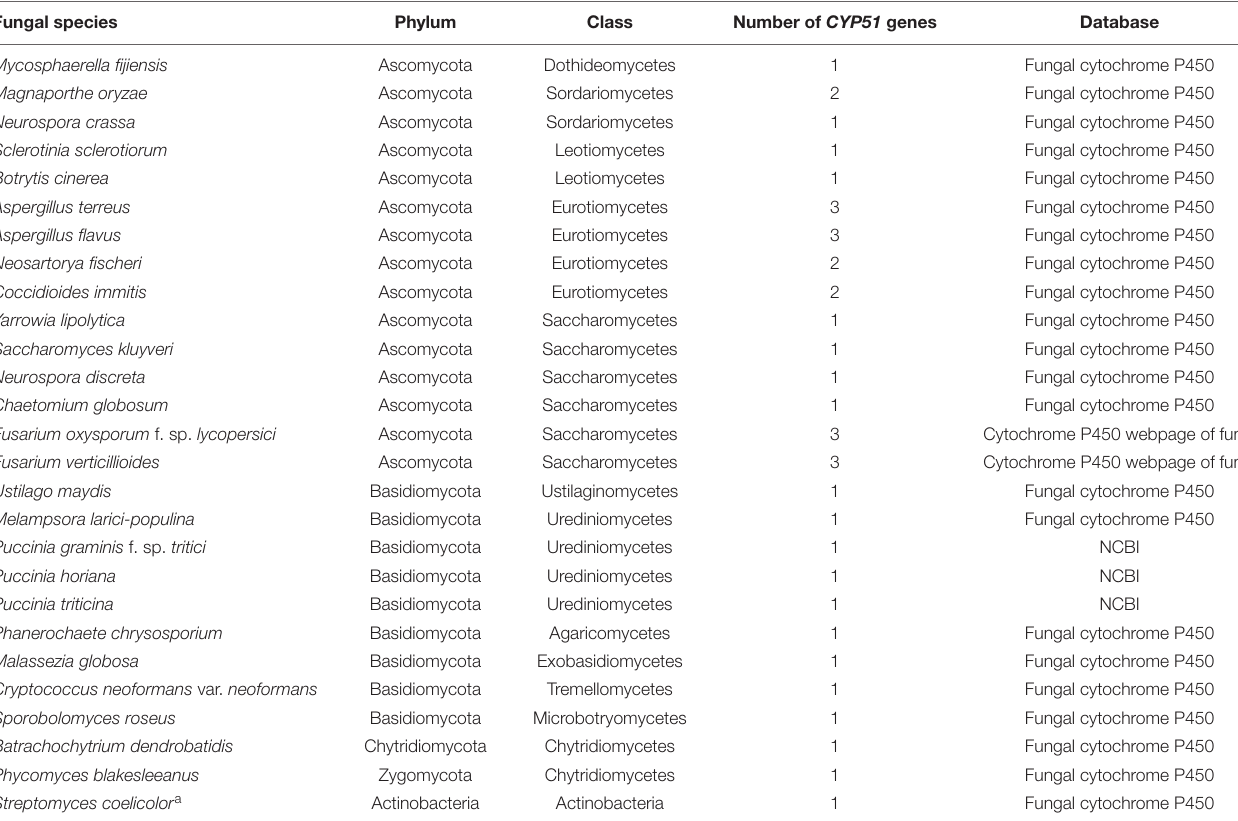
TABLE 1 | Fungal species used to compare sequences of gene CYP51